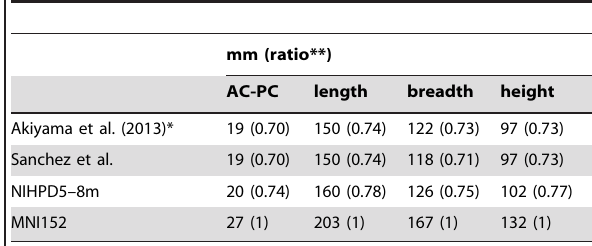
Table 2. Global shape analysis of the average